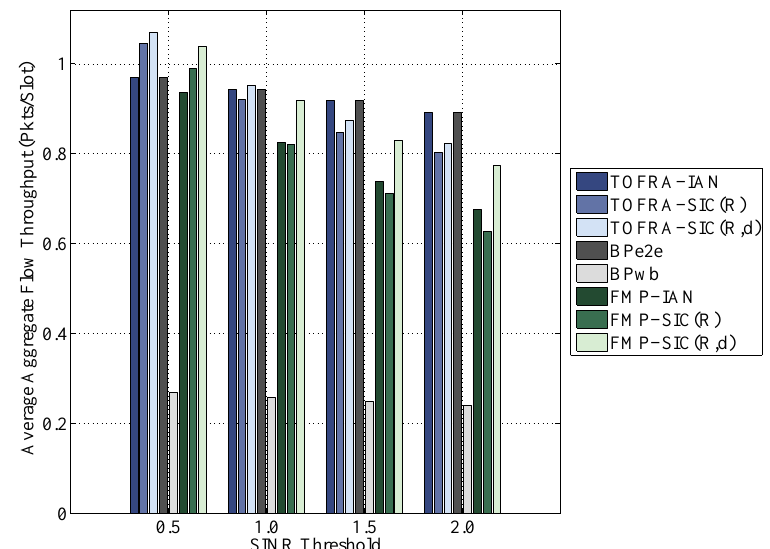
Figure 3. Topology 1: AAT per flow allocation variant.